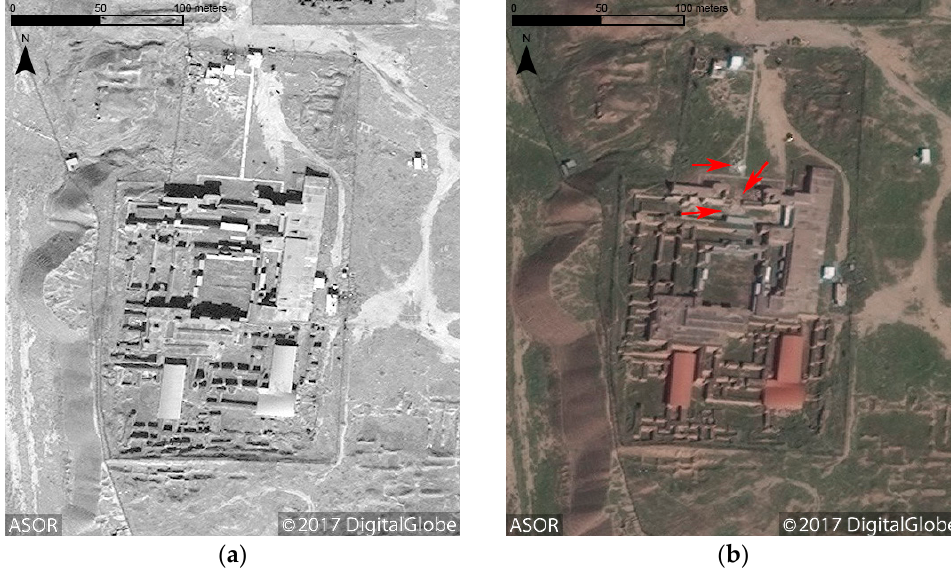
Figure 4. The Northwest Palace at Nimrud in DigitalGlobe satellite imagery ( a ) prior to damage from ISIS with protective roofing over the stone reliefs in situ (DigitalGlobe NextView License; 26 February 2015); ( b ) with arrows indicating a pile of rubble and vehicle tracks within the palace walls (DigitalGlobe NextView License; 7 March 2015).